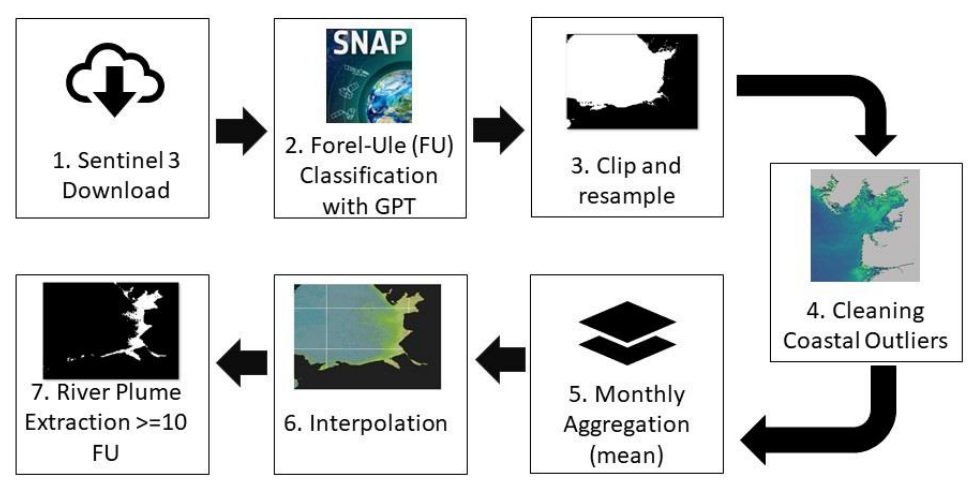
Figure 3. A schematic diagram of the methodology used to extract river plume in Liverpool Bay.